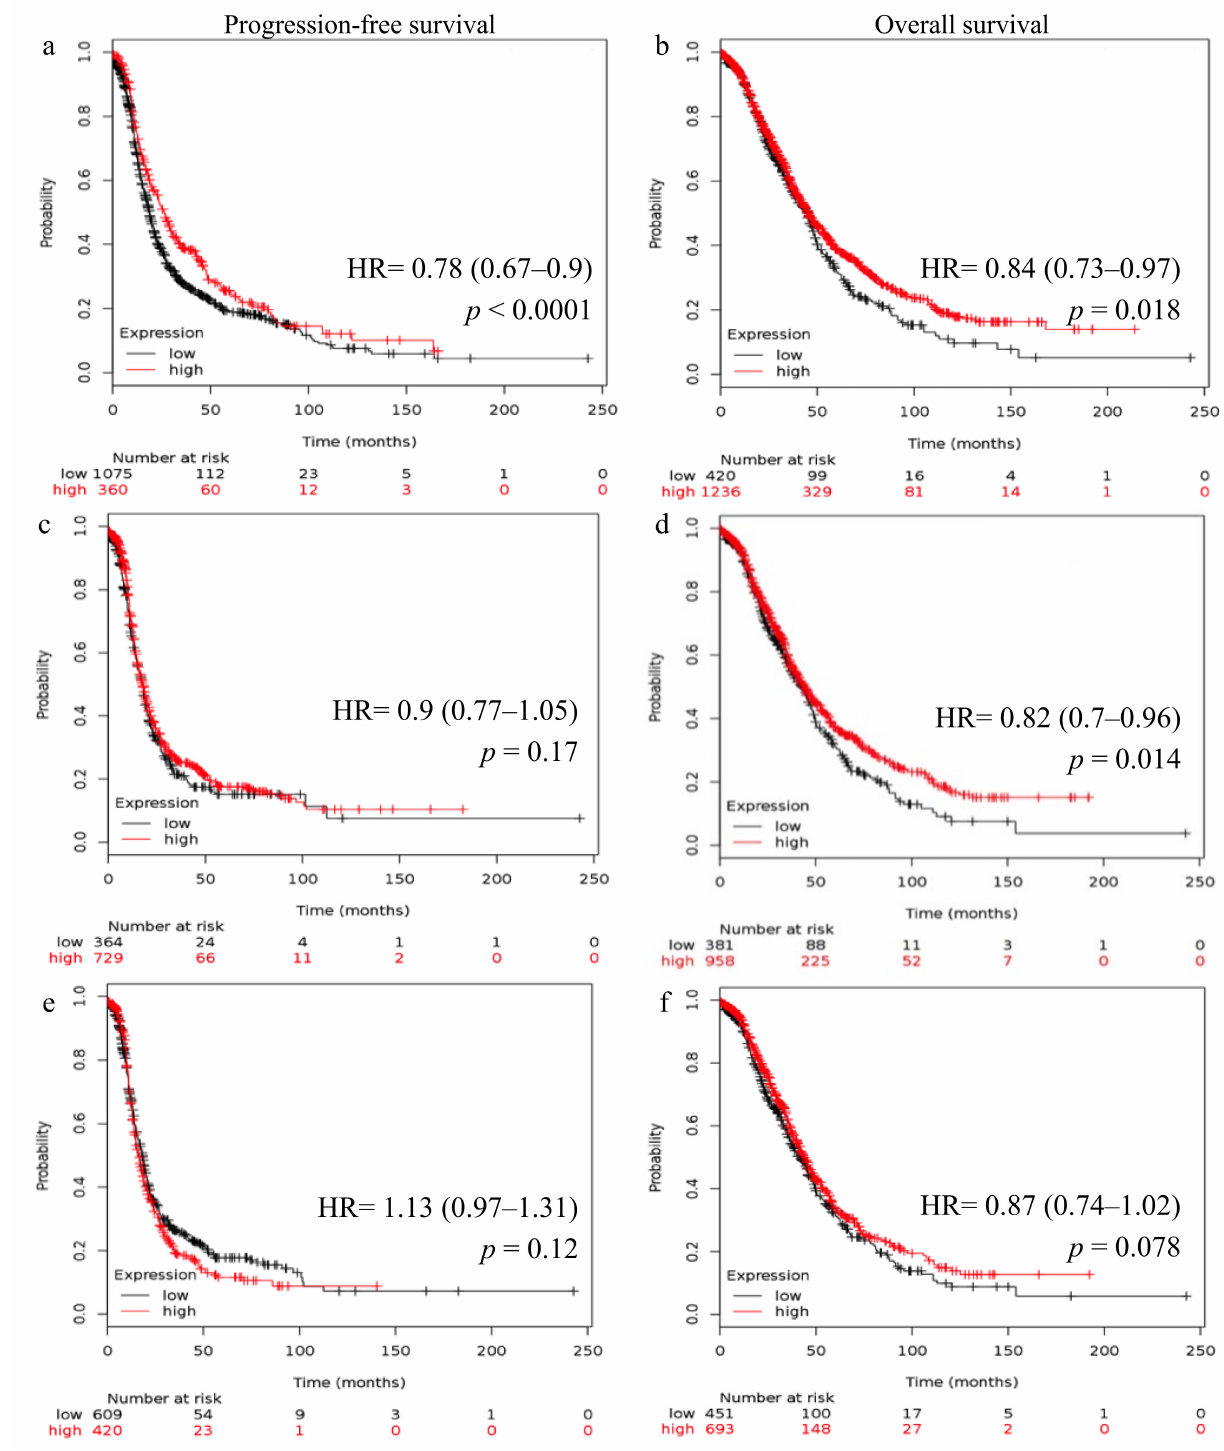
Figure 4. Kaplan Meier survival analysis showing association of LHCGR mRNA expression with ovarian cancer patient outcome. ( a ) LHCGR , all ovarian cancers ( n = 1435), progression-free survival (PFS). ( b ) LHCGR , all ovarian cancers ( n = 1656), overall survival (OS). ( c ) LHCGR , high-grade ovarian cancers, ( n = 1093), PFS. ( d ) LHCGR , high-grade ovarian cancers, ( n = 1339), OS. ( e ) LHCGR , serous high-grade ovarian cancers, ( n = 1029), PFS. ( f ) LHCGR , serous high-grade ovarian cancers ( n = 1144), OS. Patients were grouped using the best cut-off and hazard ratio (HR), 95% confidence intervals and log-rank p were calculated by the Kaplan–Meier online plotter tool